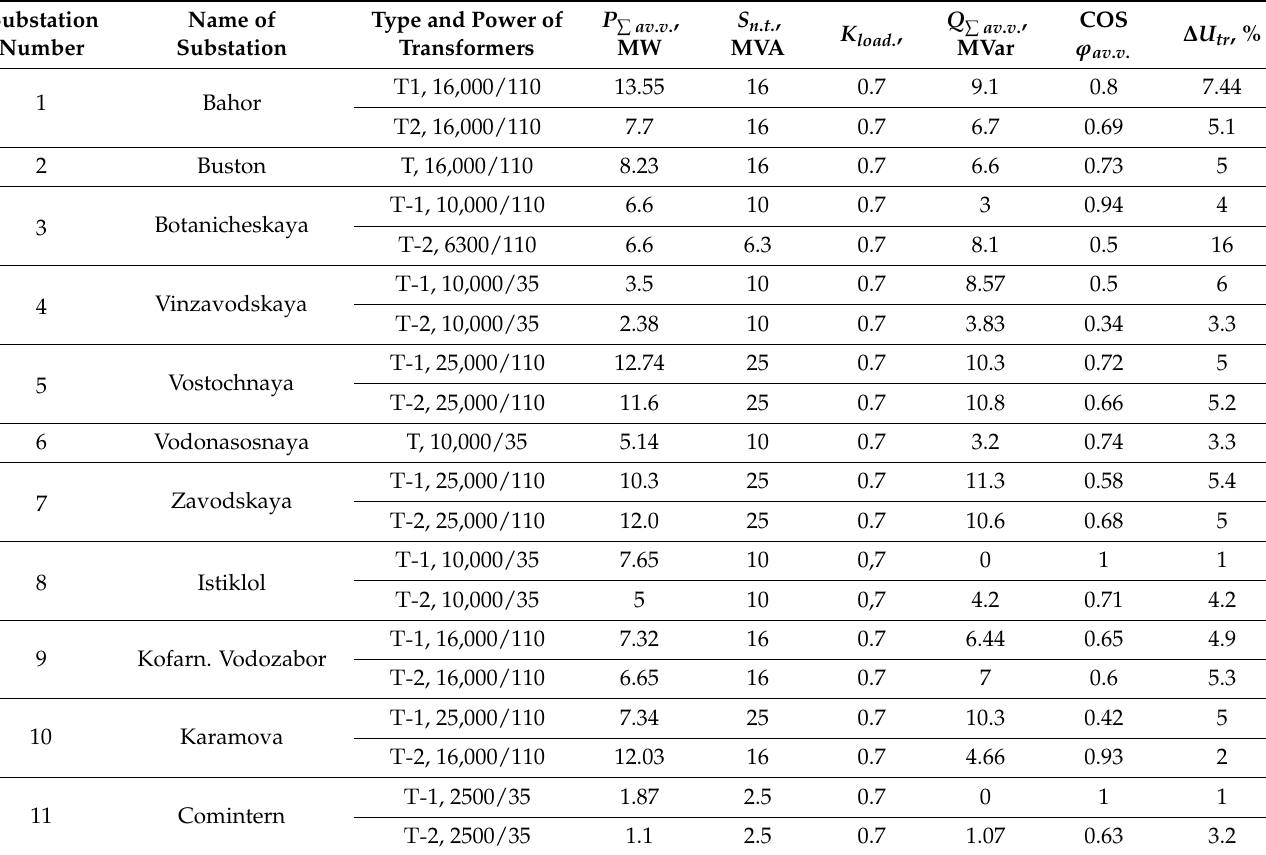
Table 1. Dependence of active power coefficients on reactive power consumption at the rated load of